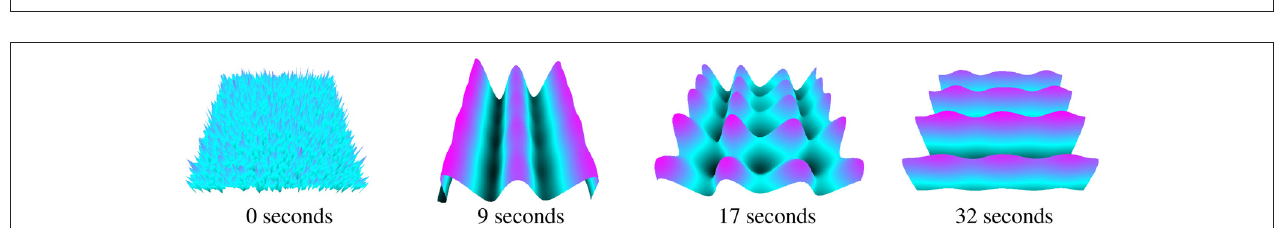
FIGURE 5 | Static Turing pattern emerging over 5s.